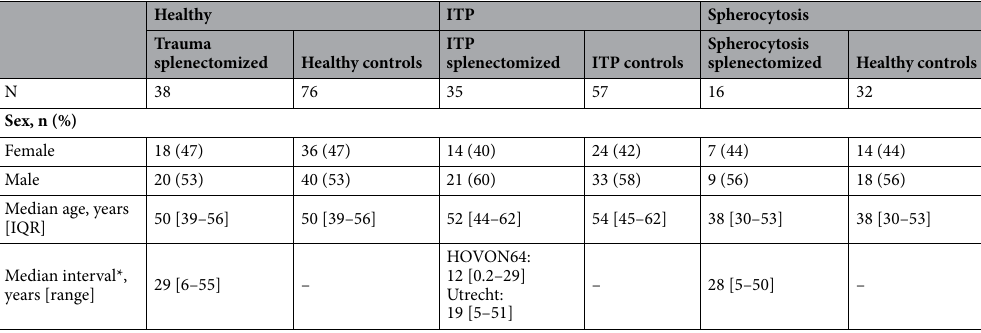
Table 1. Demographics of patients splenectomized either due to trauma or hematological diseases and non- splenectomized matched controls. *Median interval between splenectomy and blood